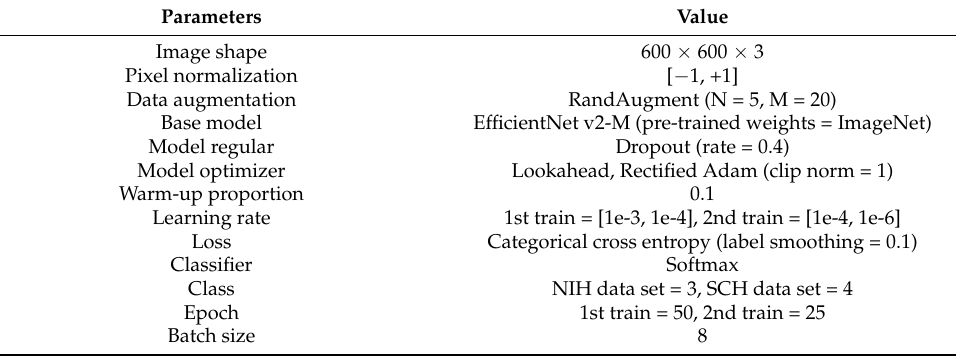
Table 8. Summary of our empirical